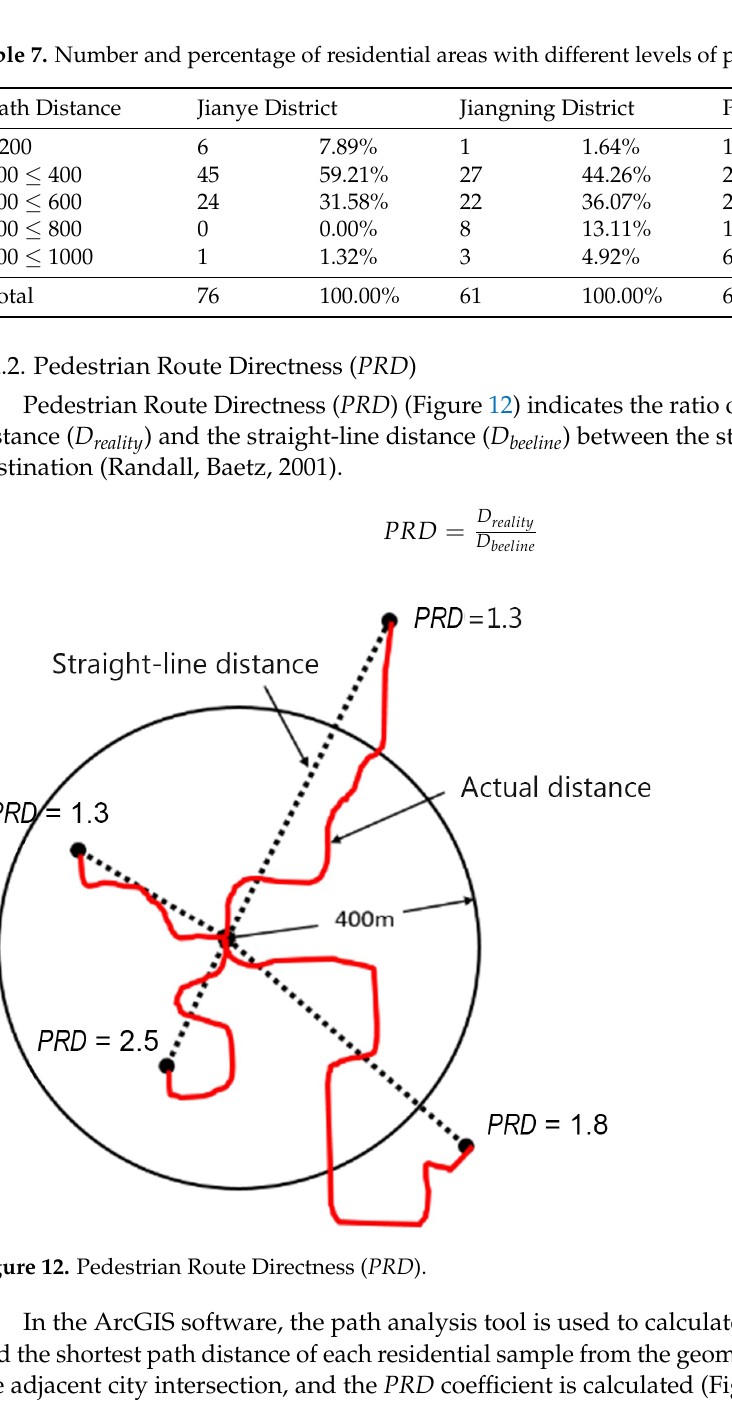
Figure 13. Average PRD of 204 residential areas in Jiangning, Jianye, and Pukou District.